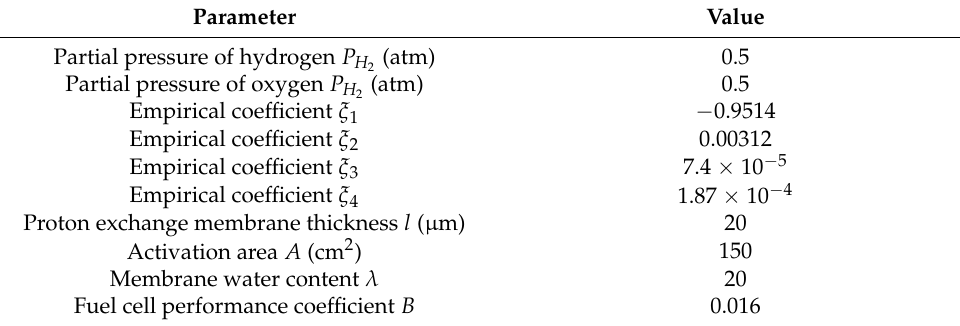
Table 1. Parameters of the fuel cell